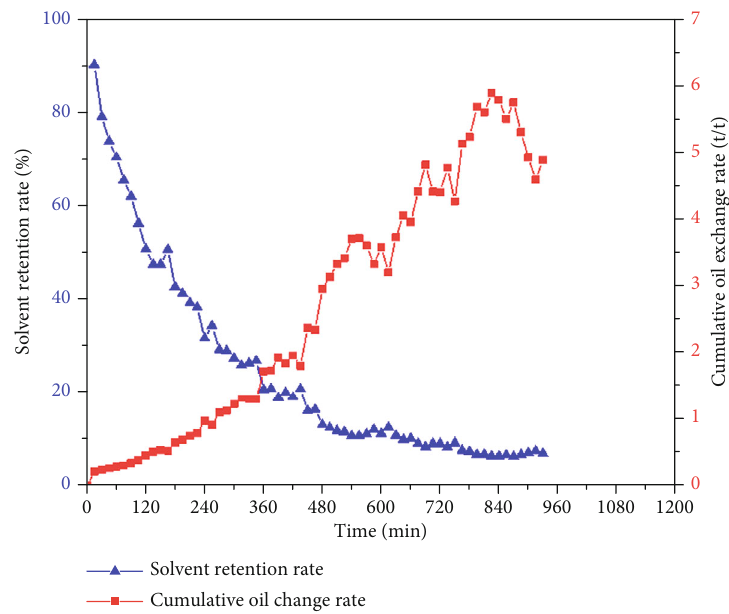
Figure 13: Change in solvent retention rate and cumulative oil exchange rate with time in Experiment 2.